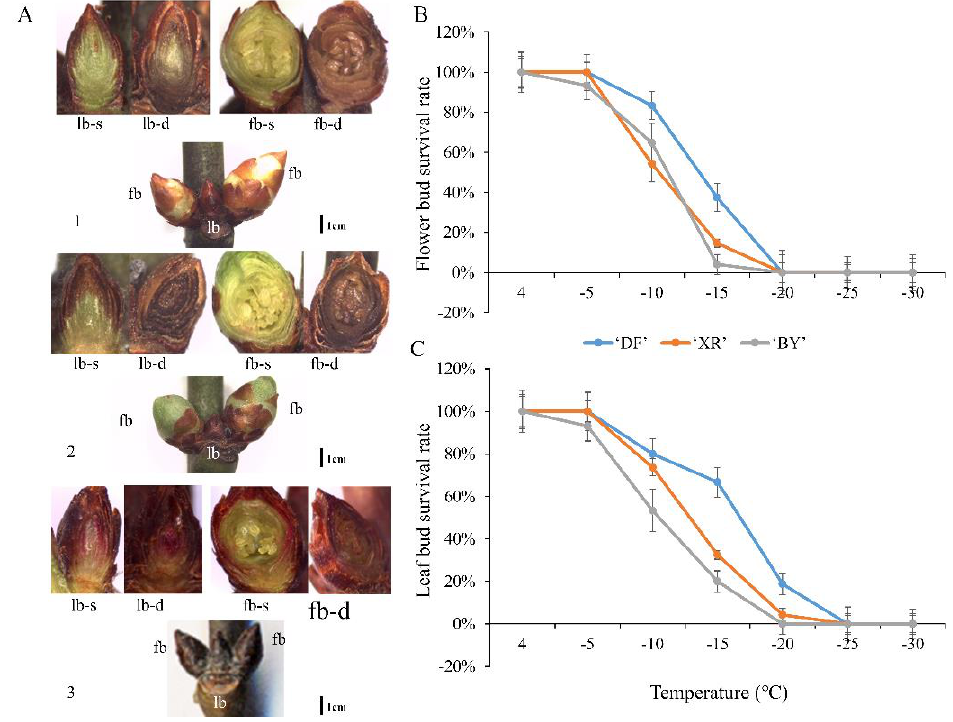
Figure 5. Anatomical states of survival or frozen death of leaf buds and flower buds, and survival rates of three P. mume varieties. Morphological and anatomical images of flower buds (fb) and leaf buds (lb): ( A ), 1 – 3 are BY, XR, and DF, respectively. lb-s, leaf bud survival; lb-d, leaf bud death; fb-s, flower bud survival; fb-d, flower bud death. Flower bud ( B ) and leaf bud ( C ) survival rate of three P. mume